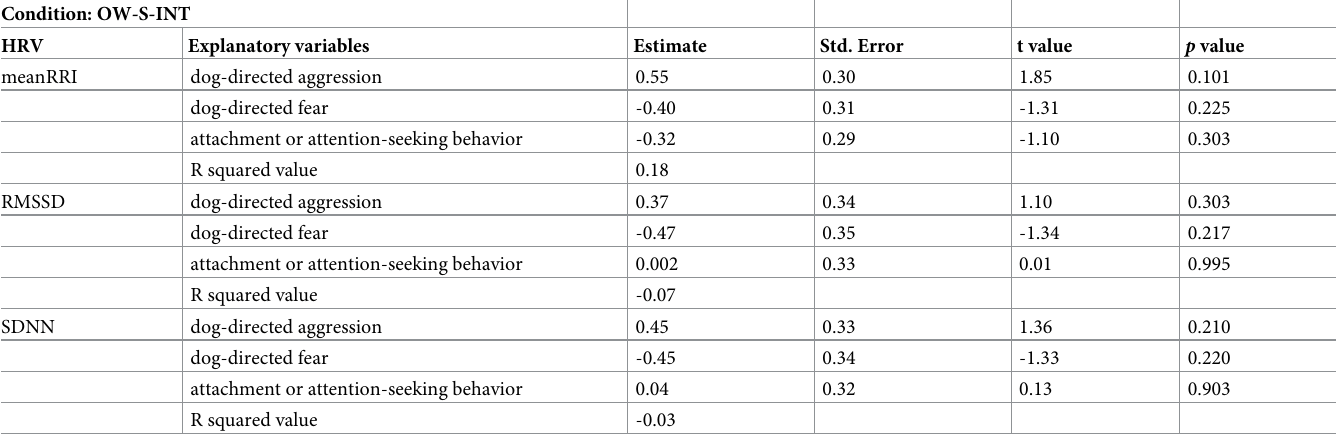
Table 3. Parameter estimates for the relationship using HRV data as the dependent variable and CBARQ scores as the explanatory variable in the OW-S-INT condition. Condition: